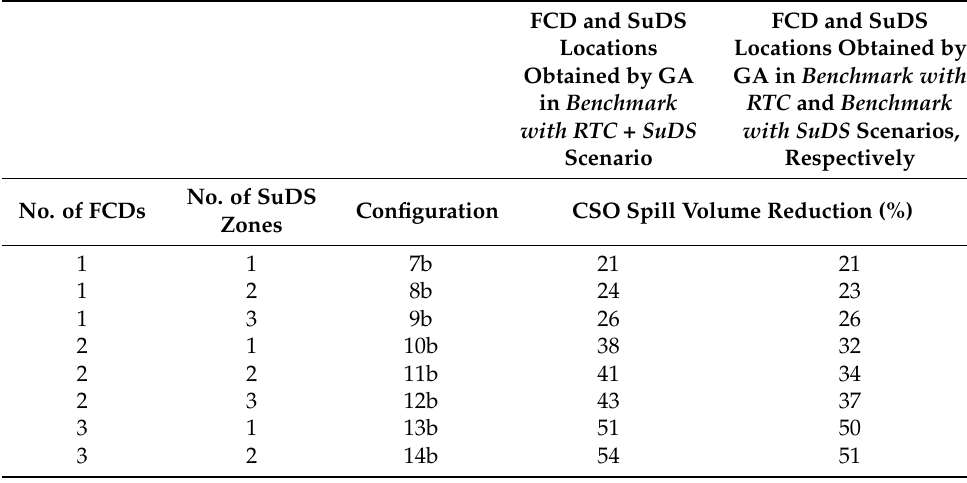
Table 4. Comparison between CSO spill volume reductions obtained by simultaneous and separate optimizations of FCD and SuDS locations within the Zona Central catchment.